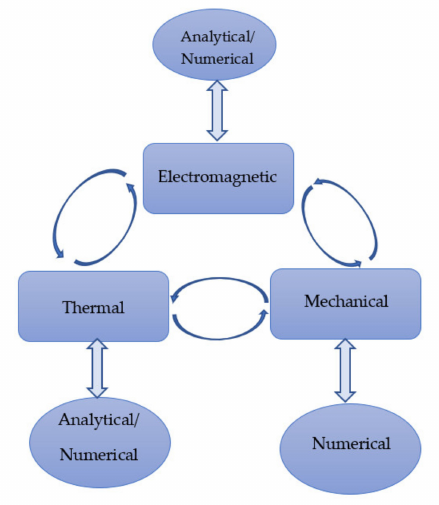
Figure 5. Multi-domain design procedure for high-speed induction motors.